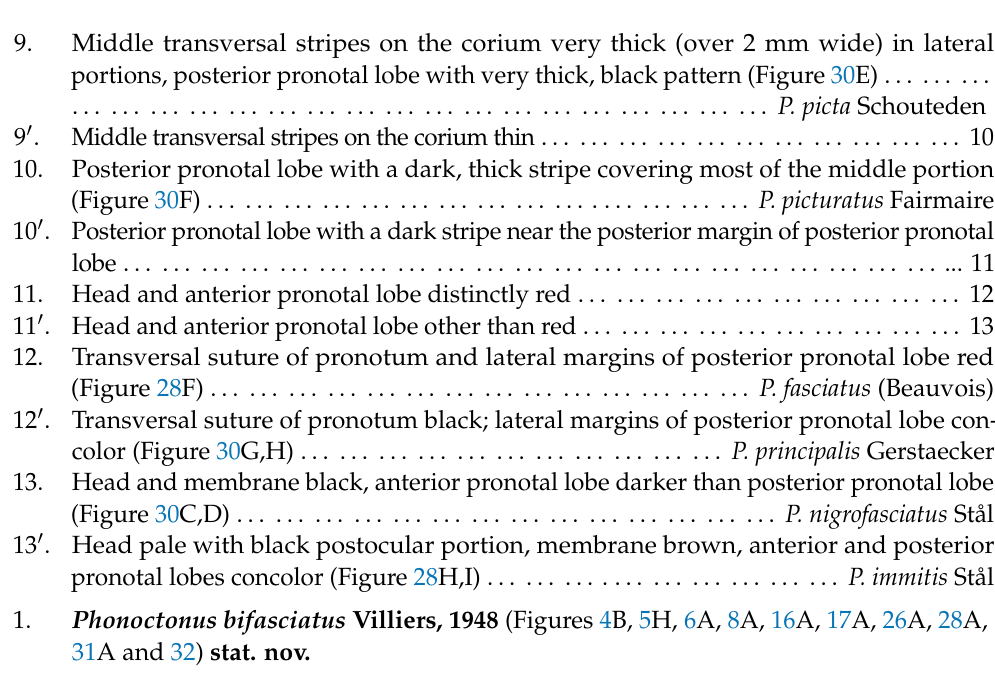
Posterior pronotal lobe with a dark, thick stripe covering most of the middle portion